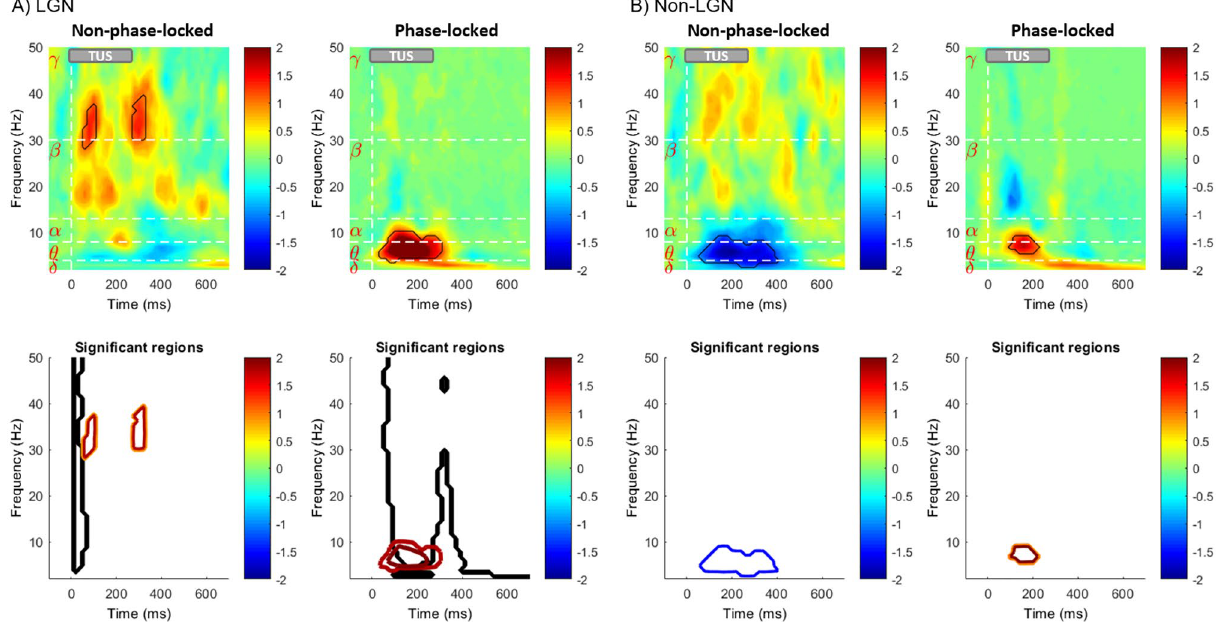
Figure 6. Immediate impact of LGN TUS on Non-phase-locked and Phase-locked visual evoked cortical oscillations. Differences between spectra in Fig. 5. The differences are shown as spectral difference maps (upper row) for two conditions, light only and light + TUS at LGN (Column 5A) and light only and light-plus-TUS at the non-LGN control location (Column 5B). Red coloring indicates areas where TUS increased visual- evoked power, while blue coloring indicates areas where TUS decreased visual-evoked power. Each of the two conditions contains difference maps for NPL and PL analyses. For each, the contour of significant regions based on nonparametric permutation-based statistics are shown in the bottom row of each panel ( p < 0.05). Significant regions of spectral difference maps between tofu and light-only baseline condition are shown in black in lower row of column A. The black significant regions of Panel A are shown for only positive